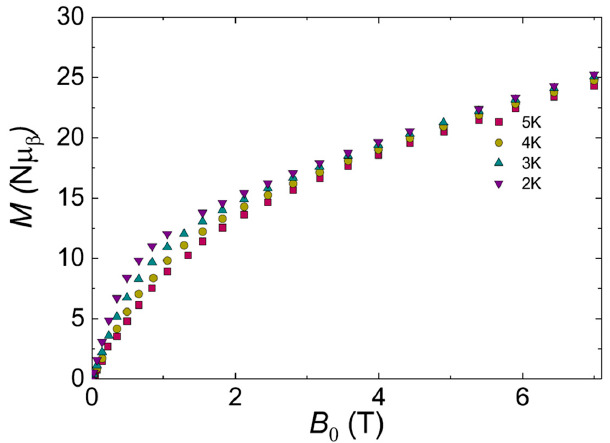
Figure 11. Experimental magnetization versus field at different temperatures ( M ( H , T )) for Dy 2 Mn 4 -P 2 W 15 .